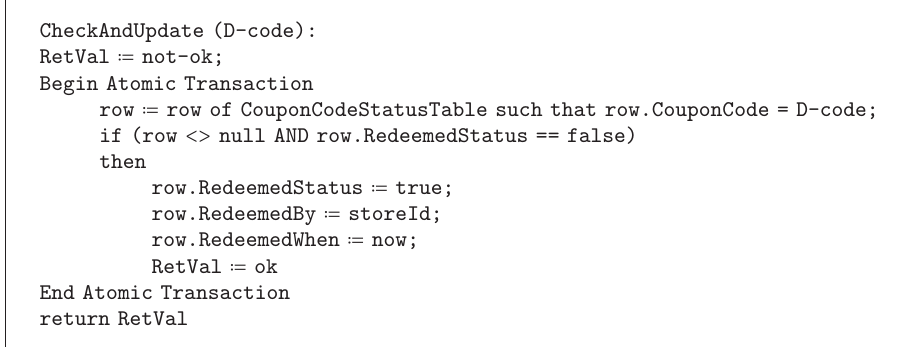
Algorithm 1: Pseudocode for request processing at the centralized service. The storeId value is an attribute of the authenticated HTTPS